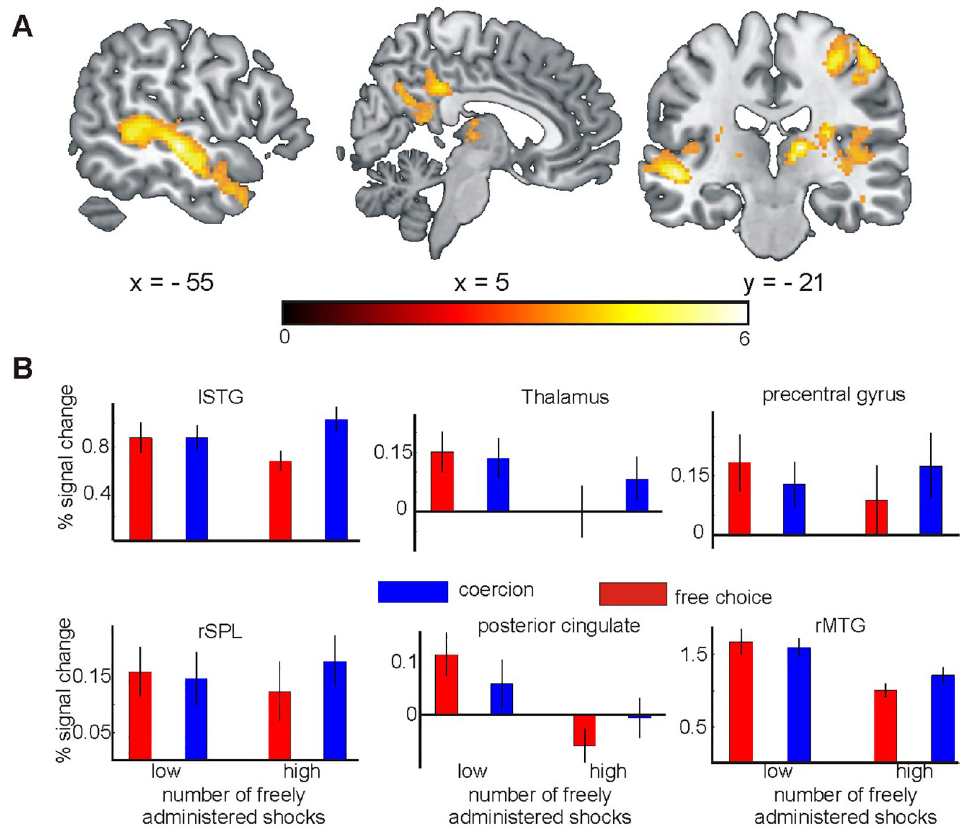
Fig 3. Interaction of freely administered shocks and coercion. Fig A shows the regression of number of freely administered shocks against the FreeChoice > Coercion contrast. For the shown regions, participants who delivered more shocks showed relatively less activity in free choice trials. B shows the median split for the regions shown in A .